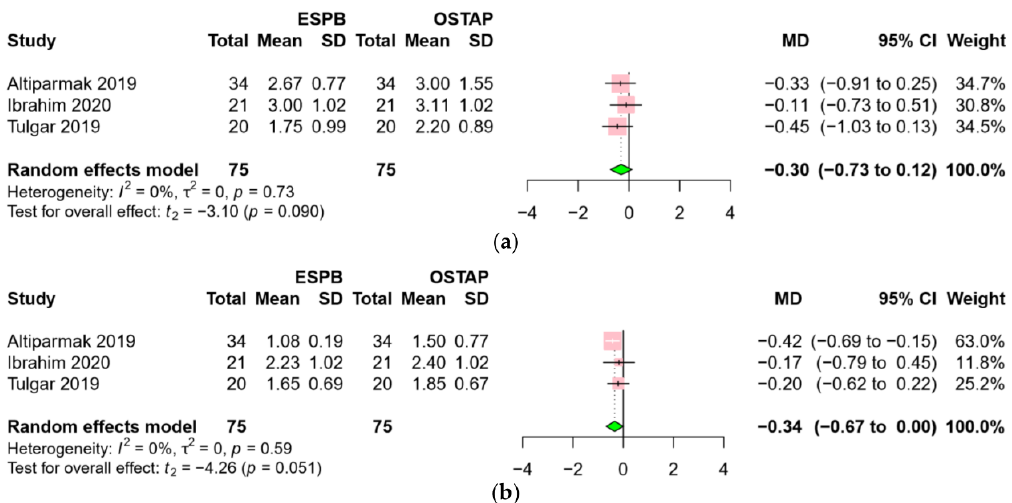
Figure 7. Forest plot for pain scores: ( a ) postoperative 12 h, ( b ) postoperative 24 h. Postoperative pain scores were comparable between the ESPB group and the OSTAP group. Abbreviations: ESPB, erector spinae plane block; OSTAP, oblique subcostal transversus abdominis plane block; MD, mean difference; SD, standard deviation; CI, confidence interval.